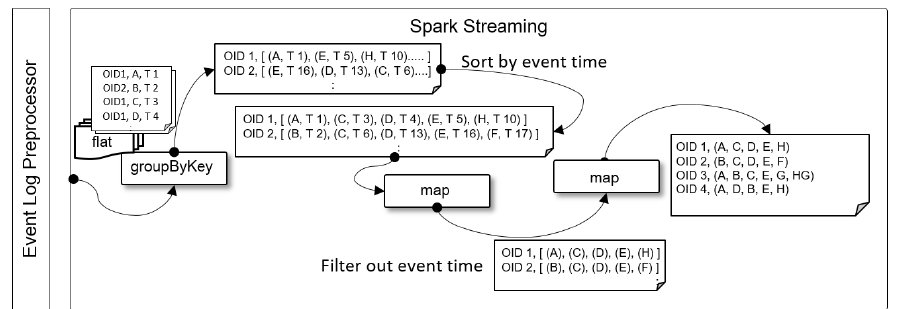
Figure 8. Examples of input and output data for the Event Log Preprocessor process.